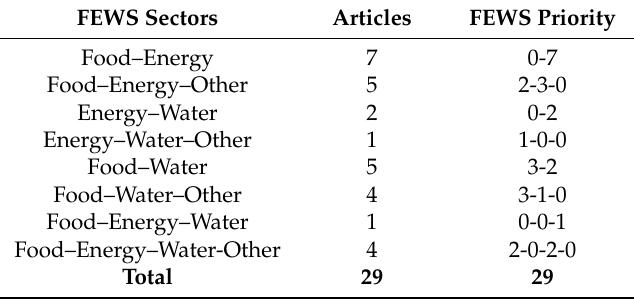
Figure 2. Food–energy–water system (FEWS) linkages studied in the reviewed agent-based modeling Figure 2. Food – energy – water system (FEWS) linkages studied in the reviewed agent-based modeling (ABM) applications. Additional interactions with climate, environmental, and / or social impacts were (ABM) applications. Additional interactions with climate, environmental, and/or social impacts were also present. also present. Table 1. Cross-sector connections explicitly modeling in ABM applications in FEWS research. The “FEWS Priority” column indicates which sector was the primary entry